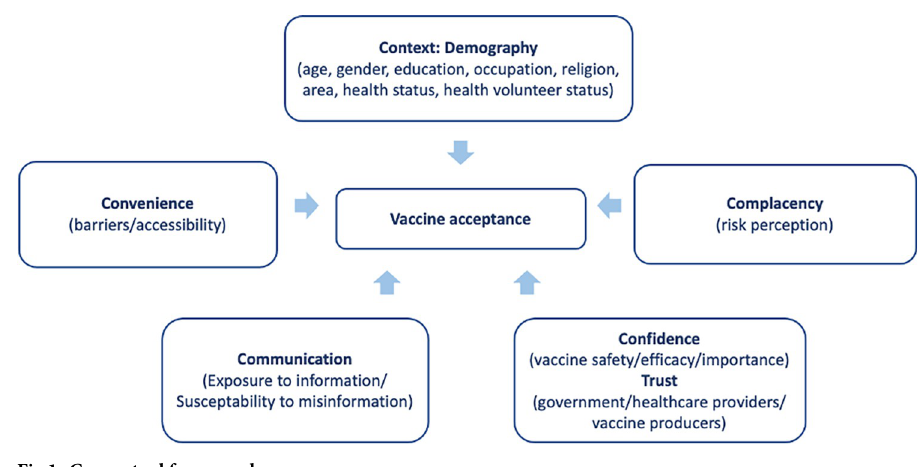
Fig 1. Conceptual